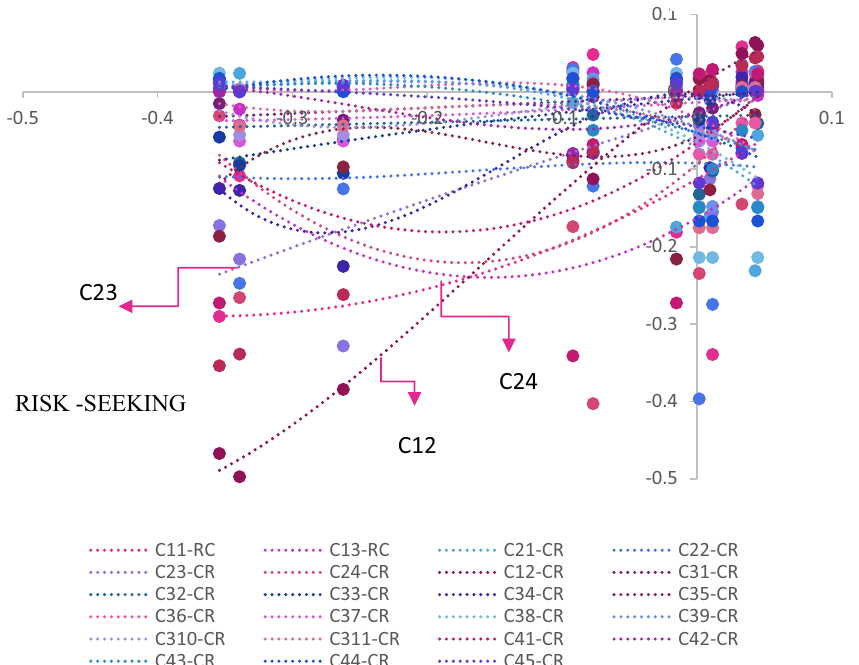
Figure 8. Risk-averse and risk seeking trend curves of criteria. Risk seeking and risk averse curves were obtained from the relative dominance degree of one alternative over other related to criteria to show how criteria impacts the overall dominance degree of alternatives. According to the reference criterion (C25) operational and maintenance cost (C23), energy savings (C24) and sludge generation (C12) criteria have the greatest influence on the determination of the overall dominance degree according to gain and loss value of criteria.